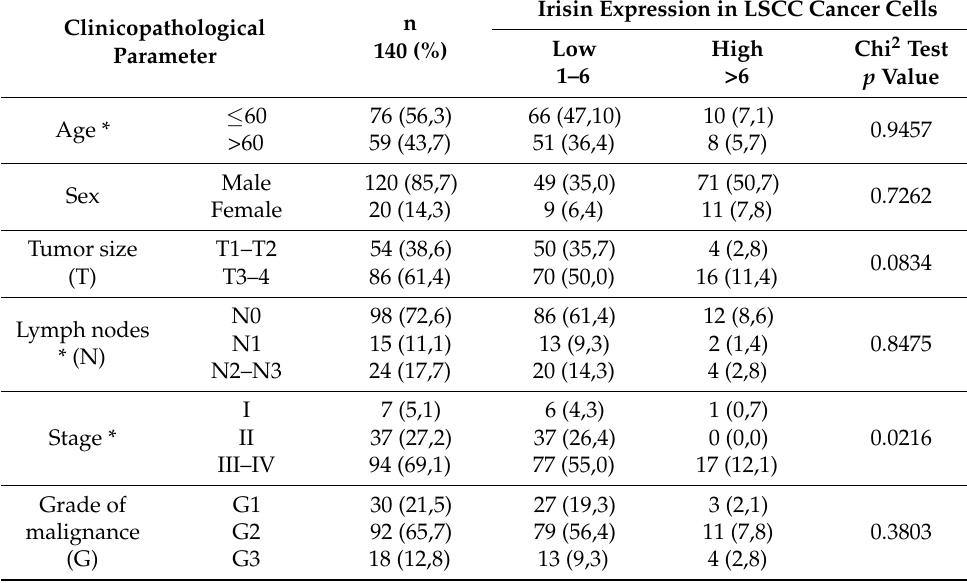
Figure 1. Immunohistochemical (IHC) reactions (brown) indicating irisin expression in the cytoplasm performed on control tissue ( A ) (magnification × 400, scale bar 20 µ m, benign lesions (BLs)) and ( B ) in laryngeal squamous cell cancer (LSCC) (low (1–6) ( C ) and high (>6) ( D )) (magnification × 200). Table 2. Clinicopathological characteristics of LSCC patients related to irisin